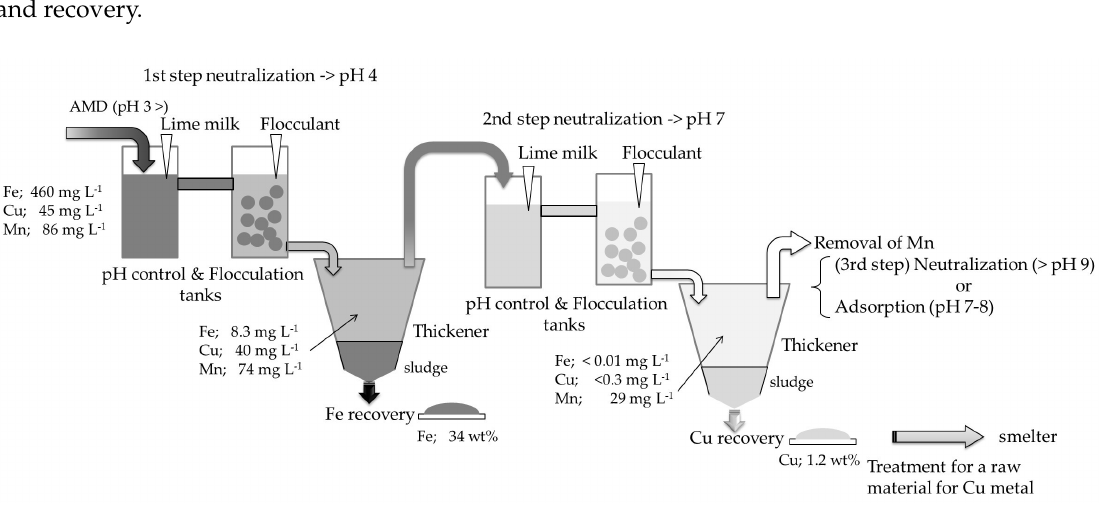
Figure 8. Schematic illustration of the assumed AMD treatment process for metal removal and